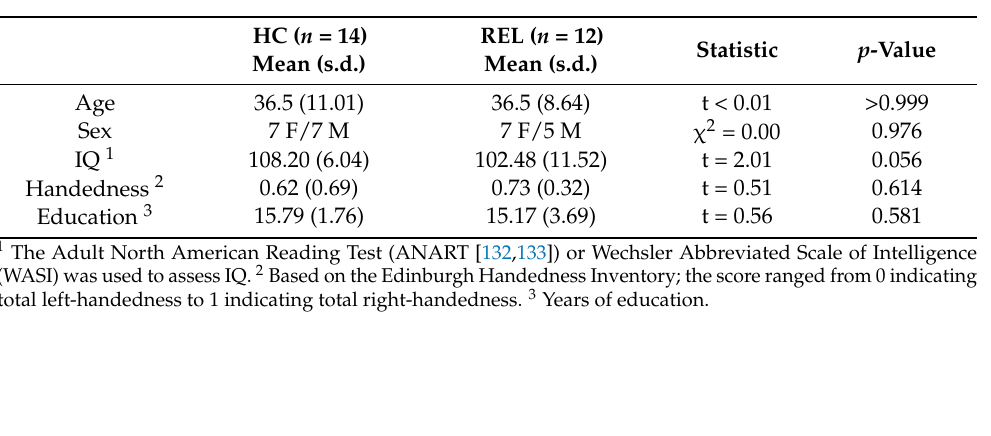
Table 1. Demographic